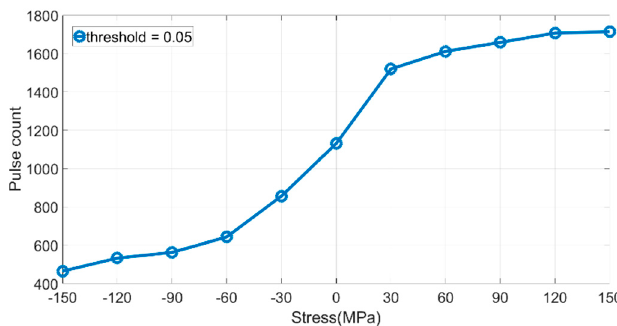
Figure 5. Example of pulse count as a function of stress when threshold = 0.05.